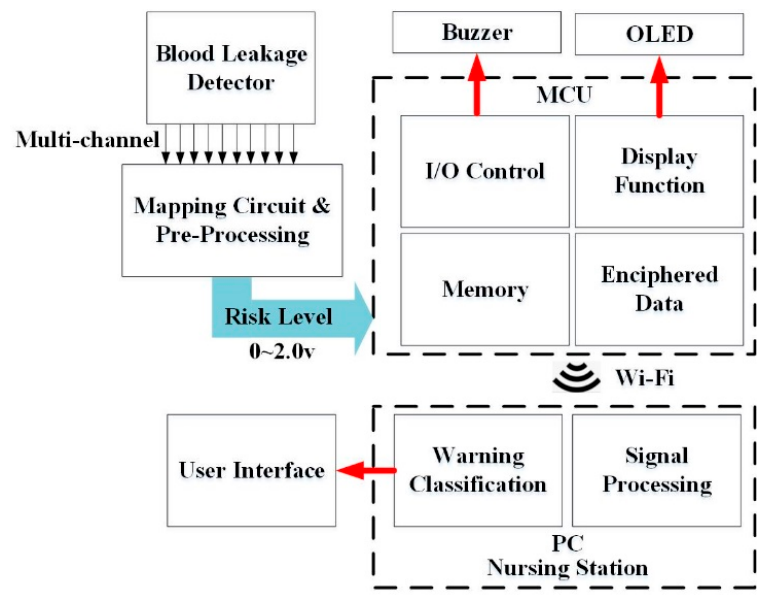
Figure 5 . Signal processing flowchart.